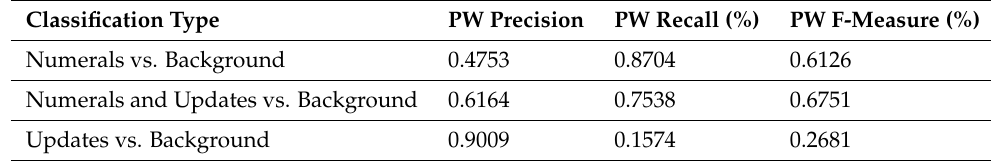
Table 3. The performance of our 3-class numeral spotting model (numerals and updates vs. background, numerals vs. background, updates vs. backgrounds) is presented with different metrics. PW stands for pixel-wise.